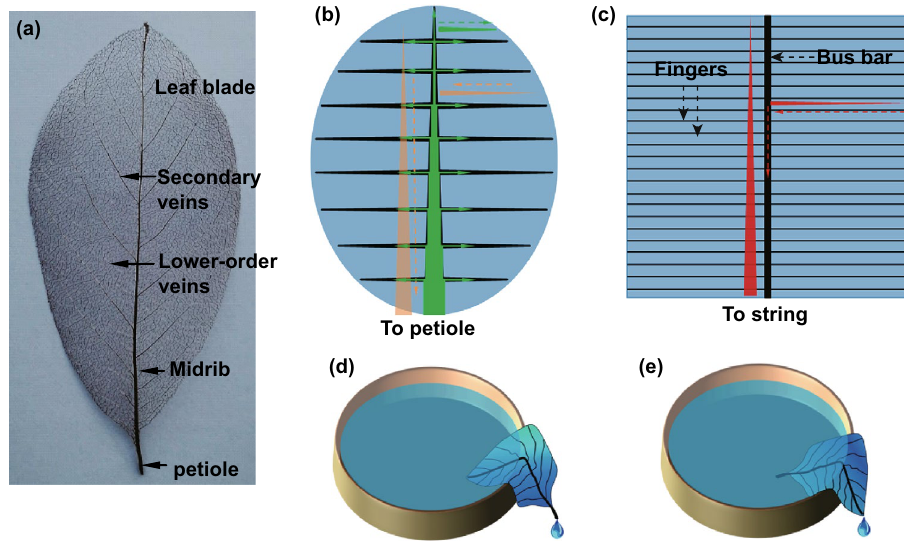
Fig. 1 a Architecture of a Magnolia liliiflora leaf vein network. b Scheme illustrating the bidirectional transport process in the leaf veins. c Current collection in solar cells by the front grid. d Demonstration of water transport from the blade (immersed in water) to the midrib through the capillaries and subsequently drops down outside the Petri dish at the petiole (Video S1). e Water is collected from the petiole to the midrib, transported through the capillaries in the midrib to the leaf tip, and drops down (Video